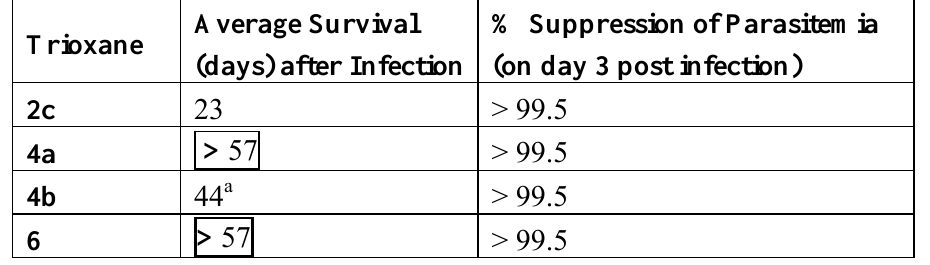
Table 1. Antimalarial Efficacy Using a Single Oral Dose of Trioxane (8 mg/kg) Combined with Mefloquine Hydrochloride (24 mg/kg) in Plasmodium berghei -infeced Mice. Average Survival Trioxane (days) after Infection